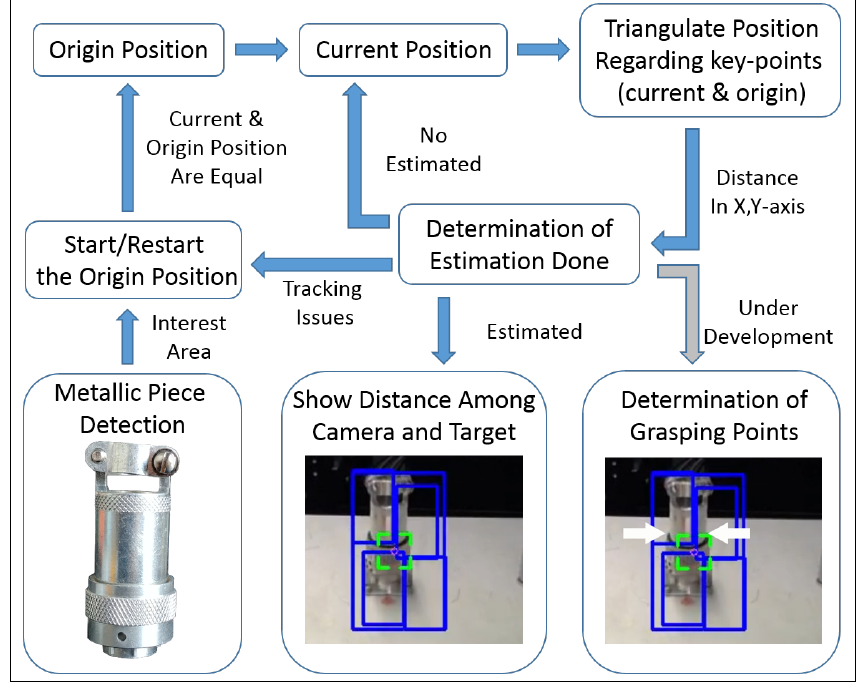
Figure 2. Diagram of the general principle of the system’